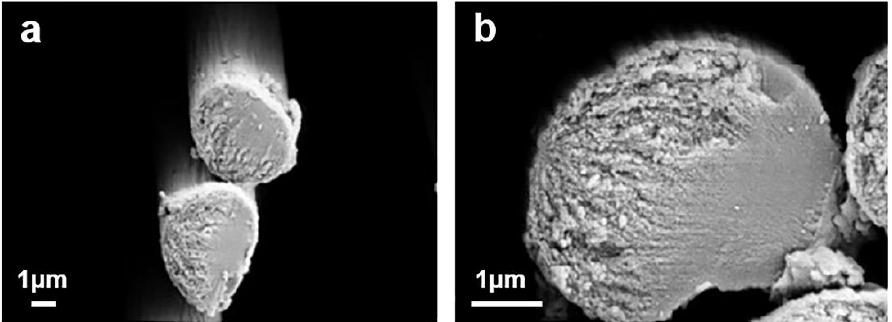
Figure 1. SEM images of carbon fibers, the magnification are ( a ) 10KX and ( b ) 30KX [7]. Copyright © 2021 Elsevier Ltd. and Carbon.